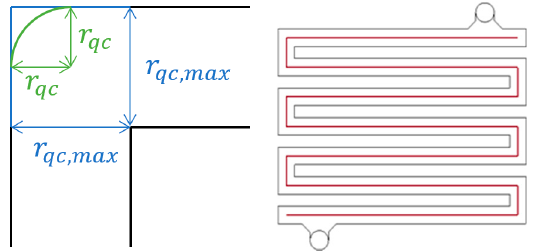
Figure 3. Graphical overview to how the “curviness” parameter ( r qc —green and r qc,max —blue) is calculated (left) at the different corners of the spacer geometry (right). The fluid flow path within the spacer is shown in red.